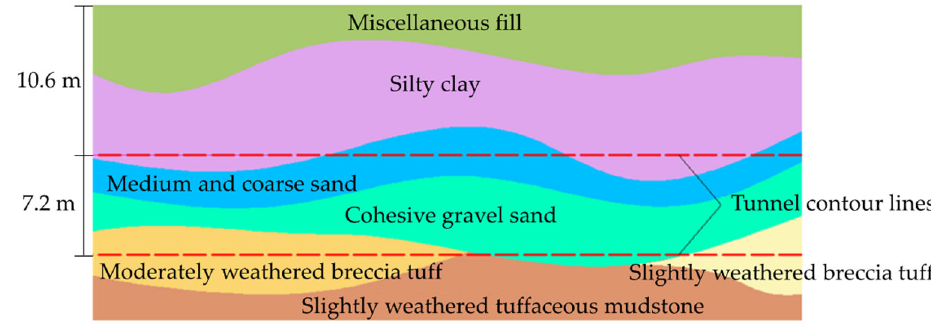
Figure 10. Geological profile. Table 2. Classification table of different strata.